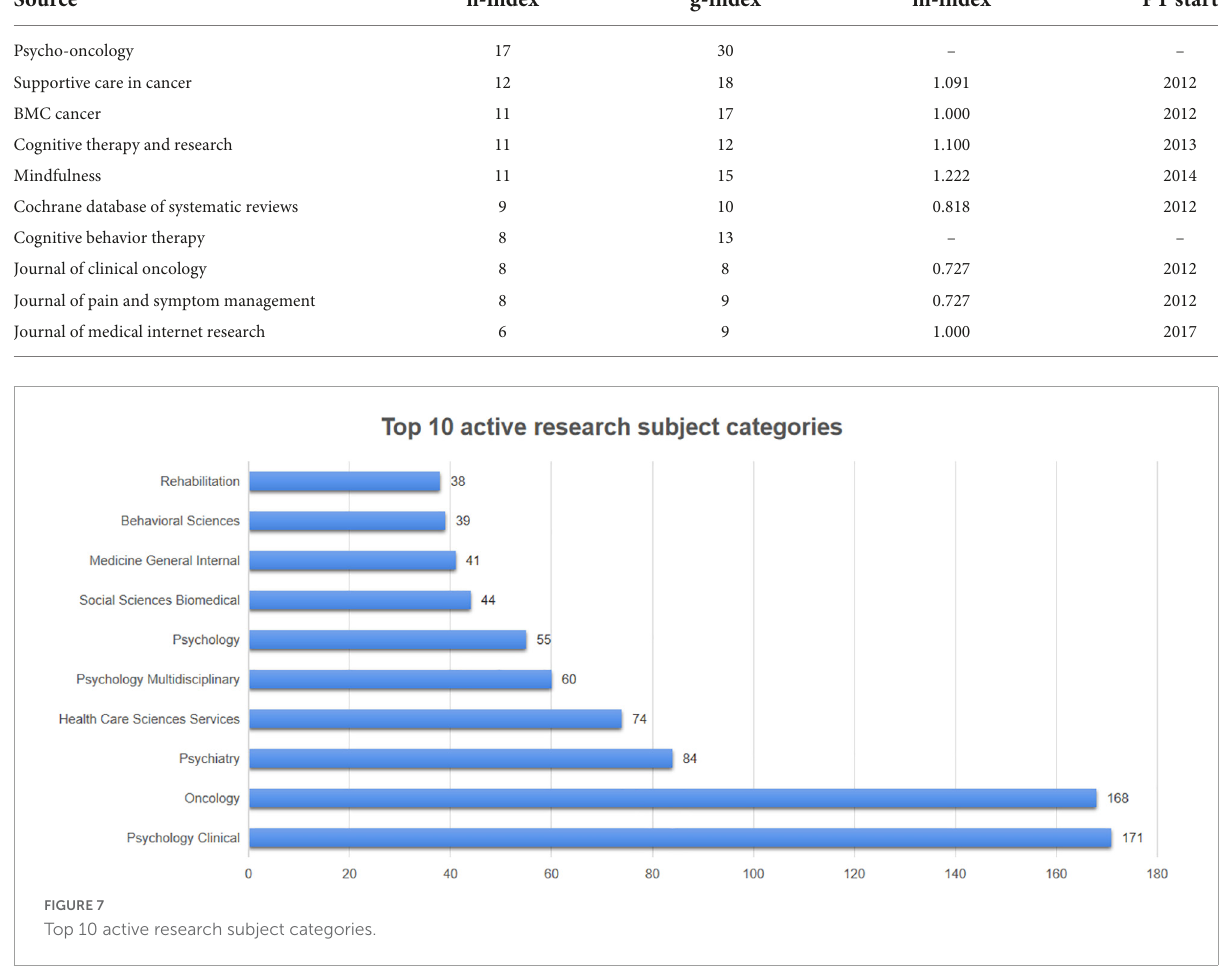
TABLE 4 Top 10 productive authors in the area of cognitive behavioral therapy and